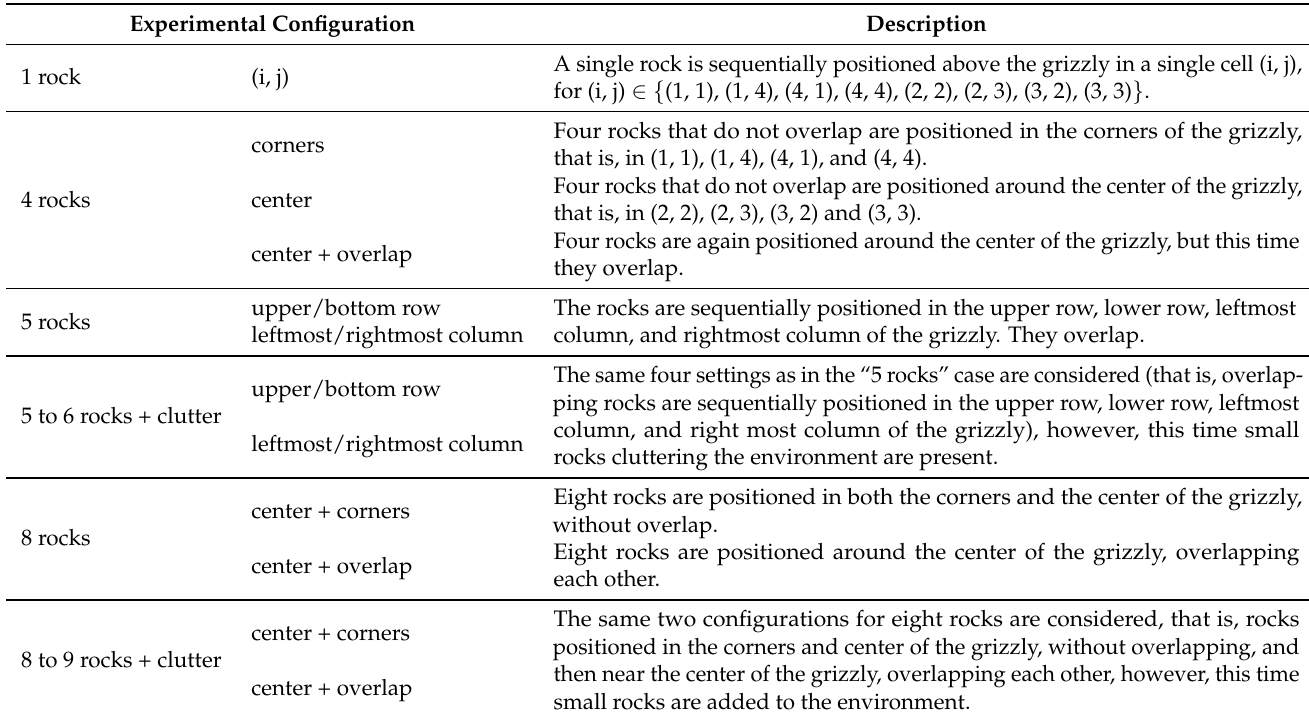
Table 1. Experimental configurations used to conduct the evaluation of the developed system, in the real world.